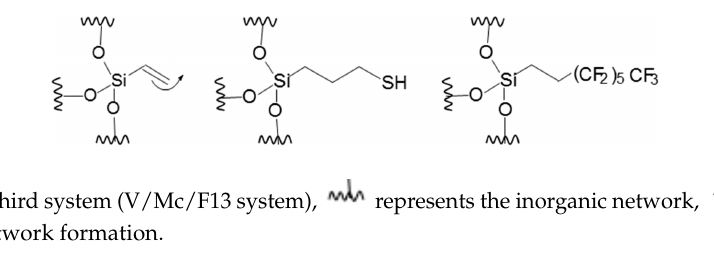
Figure 5. The third system (V/Mc/F13 system), represents the inorganic network, represents the organic network formation.